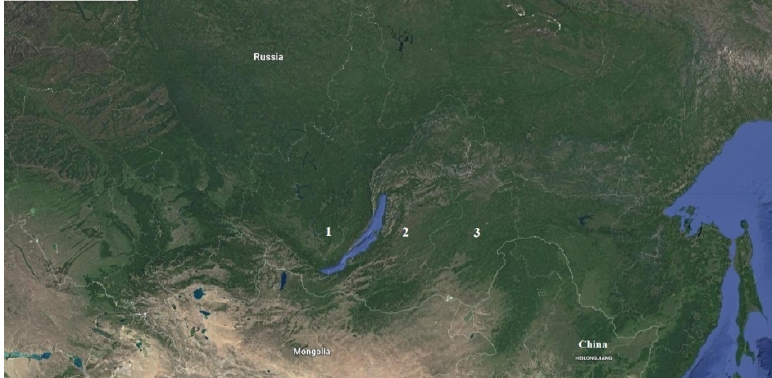
Figure 1. Baikal region (view from the satellite). Legends: 1—Irkutsk region, 2—Republic of Buryatiya, and 3—Zabaykalsky Krai.